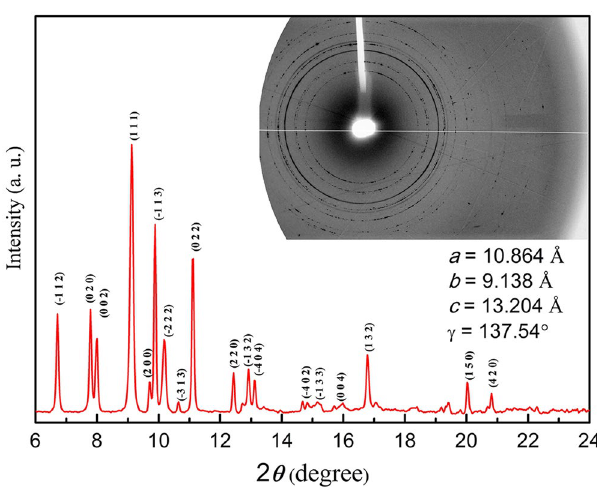
Figure 1. Images of the equilibrium forms of the p -xylene grown in the DAC. Temperature: 24–28 °C. The two spheres on the left part of the hole are the ruby balls for in situ pressure measurements.